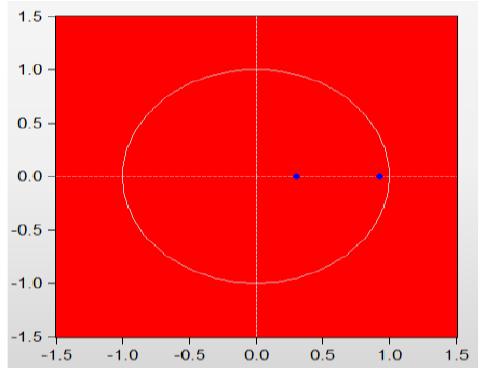
Figure 3: Inverse Roots of AR Characteristic Polynominal